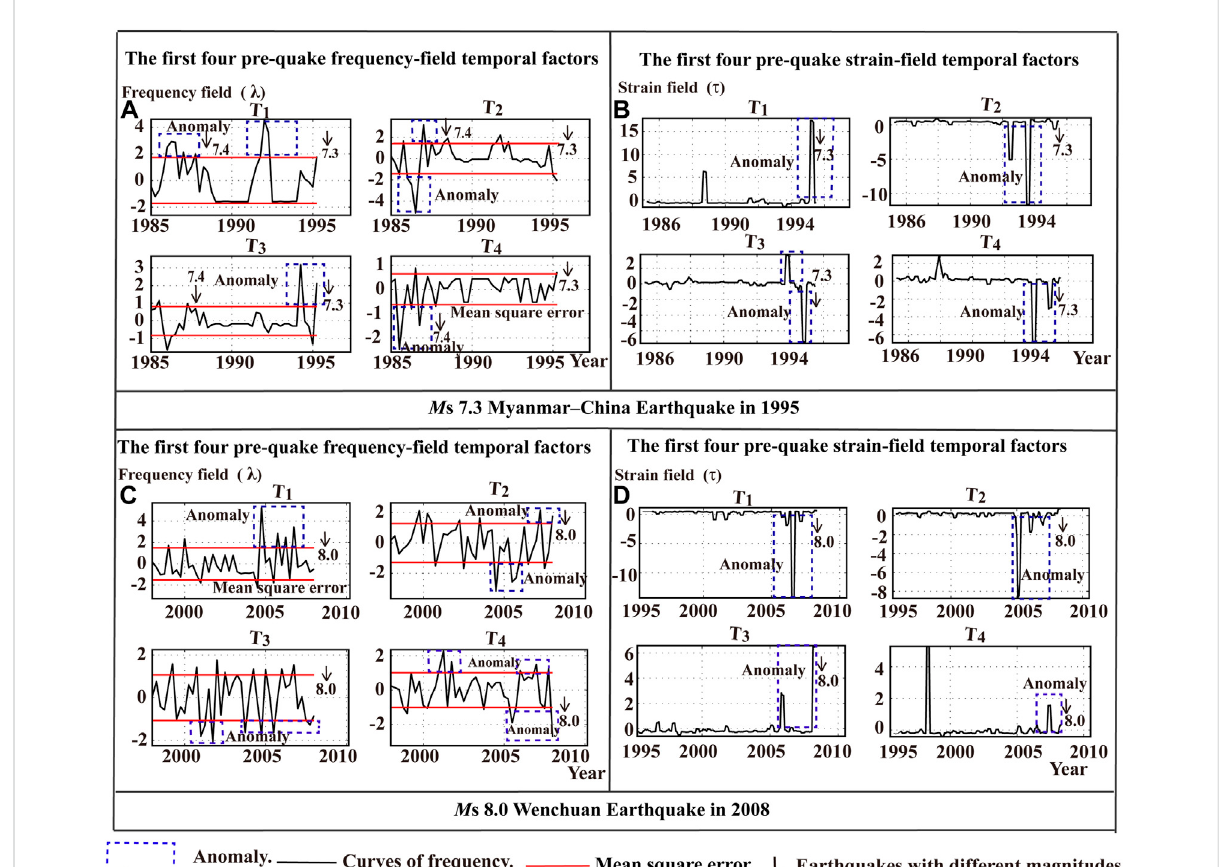
FIGURE 7 Comparison between frequency- fi eld and strain- fi eld temporal factors, the green dotted line represents the anomaly, the red line is two times the mean square error, the black arrow represents the magnitude of a M s ≥ 7.0 earthquake (A,B) the 1995 M s 7.3 Myanmar – China earthquake (top) and (C,D) the 2008 M s 8.0 Wenchuan earthquake